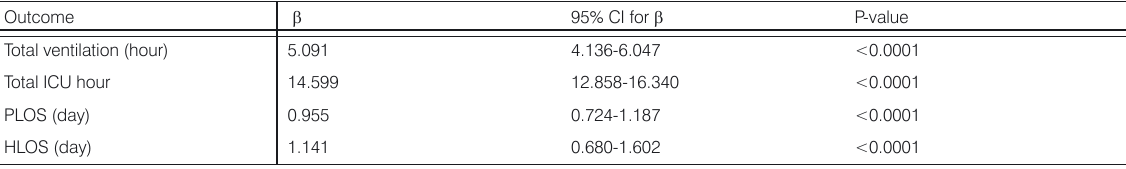
CI, Confidence interval PLOS, Post surgery length of stay HLOS, Hospital length of